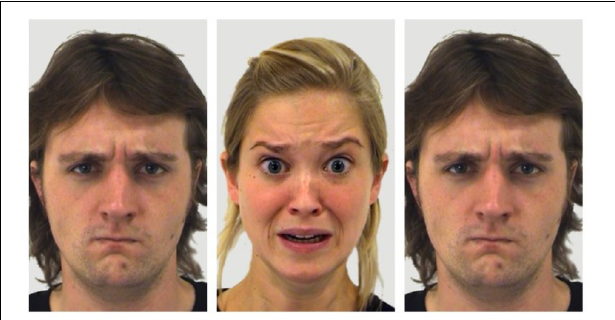
FIGURE 1 | Face flanker stimulus example showing incongruent fear (F–A). The central target face shows a fearful expression and the two flanker faces show an angry expression. These faces are from the Amsterdam Dynamic Facial Expression Set (ADFES) (Van Der Schalk et al., 2011), with the central face being identified as F03AFS, and the two flanker faces as M04ANS. Written informed consent from the depicted individuals, and permission from the copyright holders for the publication of these images, was provided by the University of Amsterdam Department of